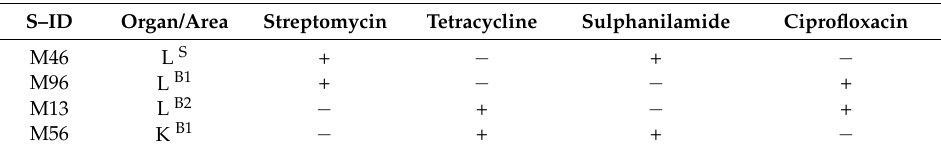
Table 6. Multi antibiotic residue in some meat samples.